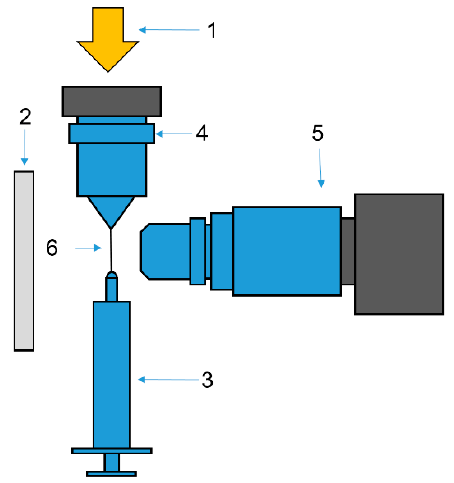
Figure 1. An experimental device for stretching a jet up to a definite length. 1 —a fiber-optic illuminator along the jet axis; 2 —back lighting; 3 —a syringe with the solution; 4 —a lens to focus the light into the center of an extended jet; 5 —a camera; 6 —a jet. This is according to [30,31].